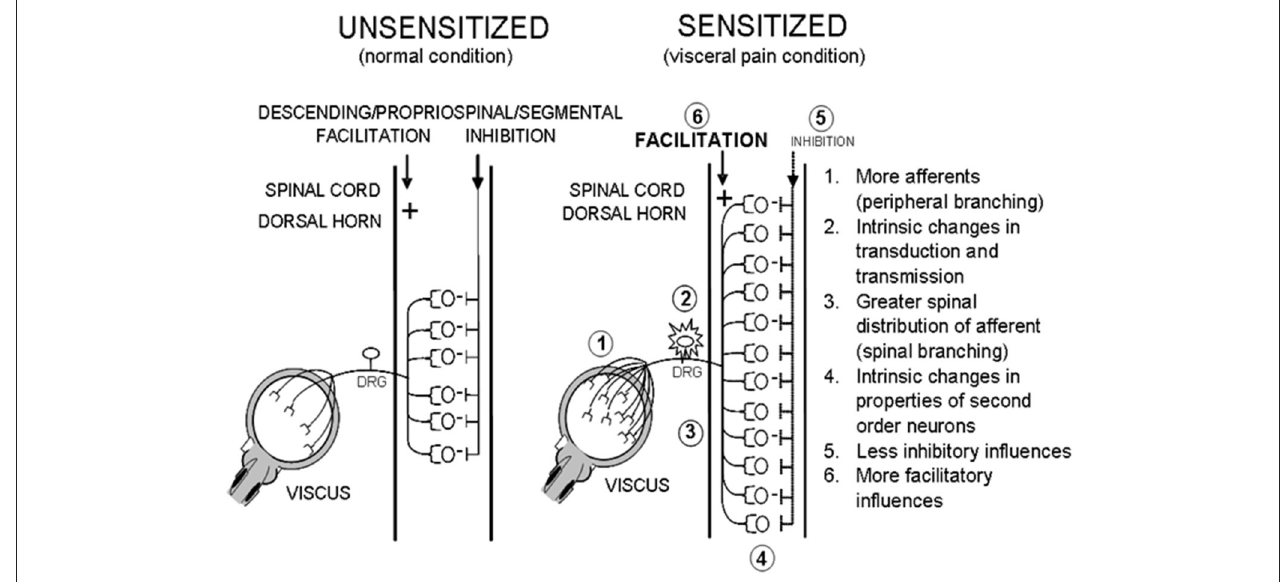
FIGURE 10 | Potential Effects of NBI. Hypothetical mechanisms that lead to a sensitized state that might occur secondary to an episode of